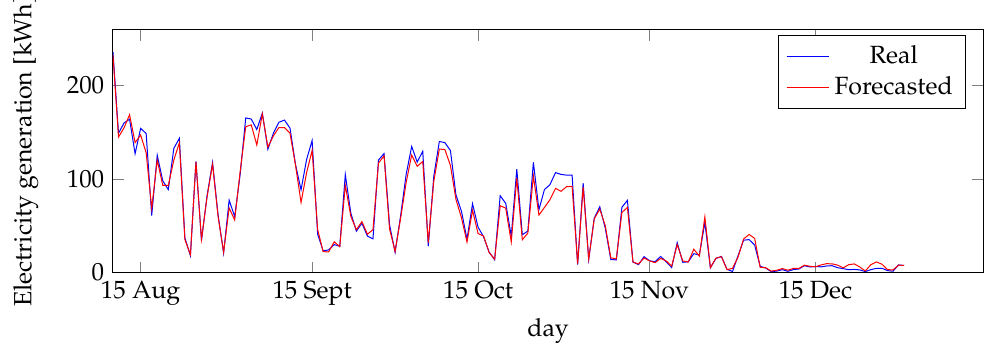
Figure 7. Forecasting results for 10 August to 31 December 2021 using GBRT.